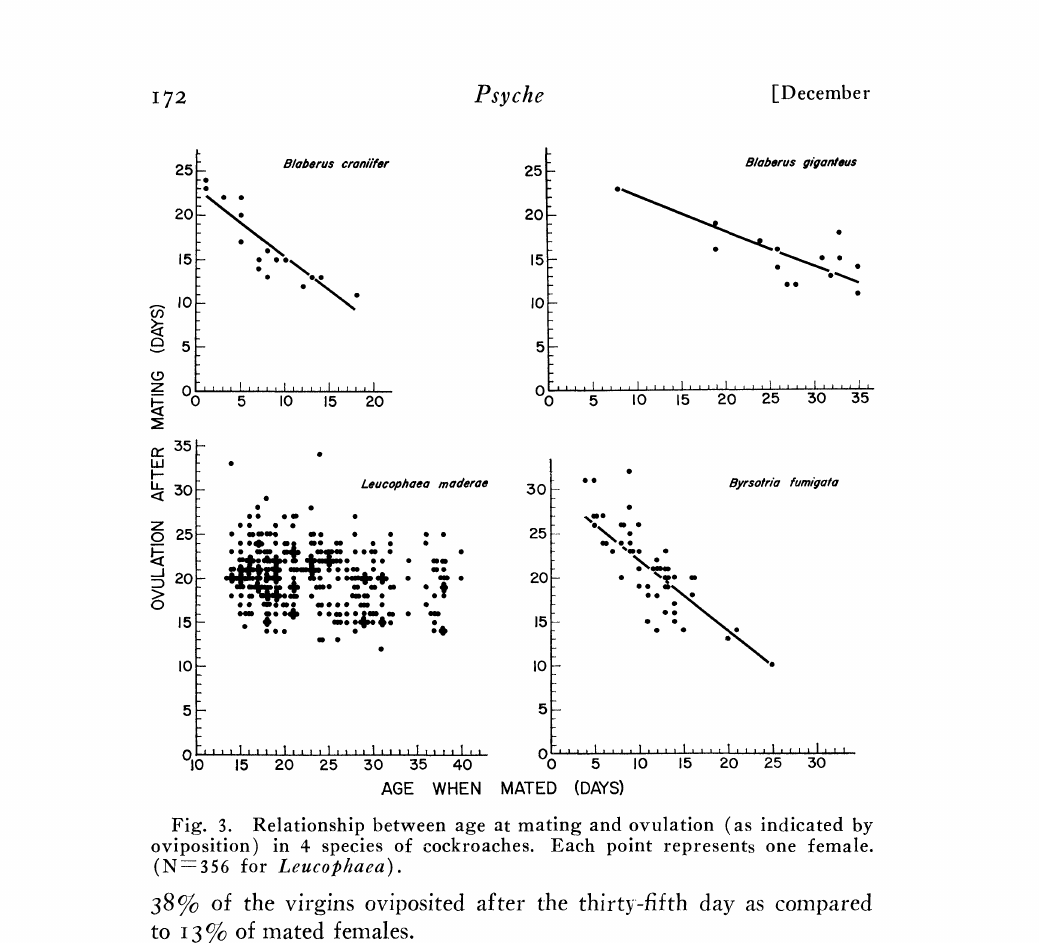
Fig. 3. Relationship between age at mating and ovulation (as indicated by oviposition) in 4 species of cockroaches. Each point represents one female. (N--356 for